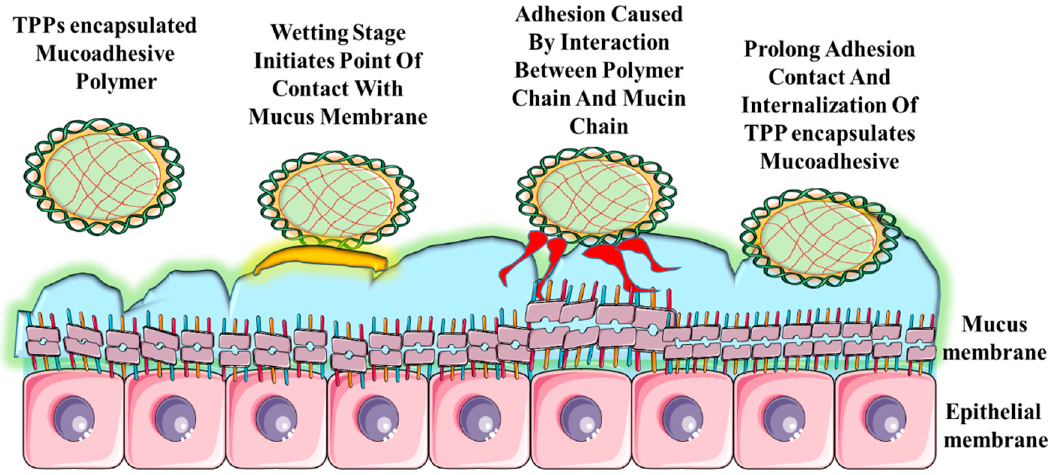
Figure 3. Steps in mucoadhesion for the mucoadhesive polymeric system. At the first stage the mucoadhesive polymer swells (contact stage). The swelling occurs because the polymer has an affinity for water. In the second stage, the polymer interacts with the mucus membrane. Weak chemical bonds form in the entangled polymer chains.